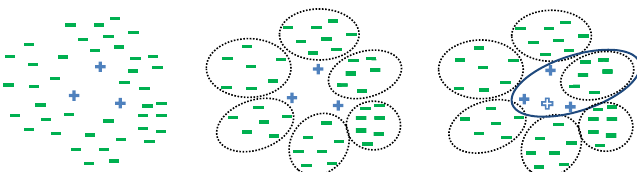
Figure 1. Characteristics of data. ( Left ): original data; ( Center ): after partition; ( Right ): after merging and over-sampling. The bars represent the majority class samples, the crosses represent the minority class samples, and the hollow cross represents the sample generated by